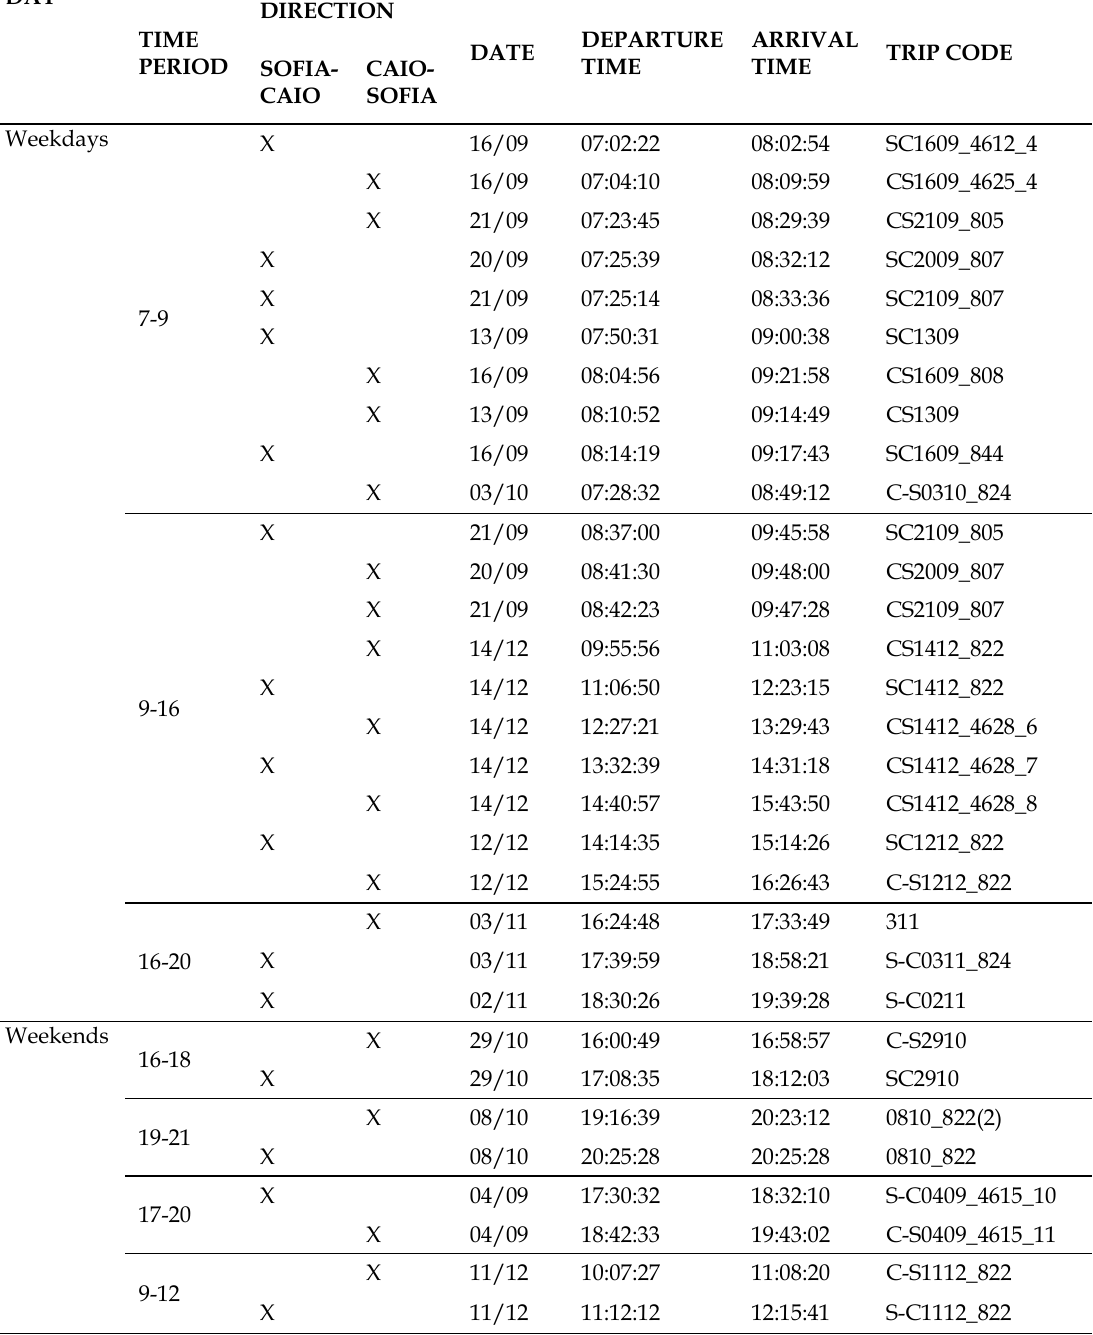
Table 1. Sampled trips from bus line